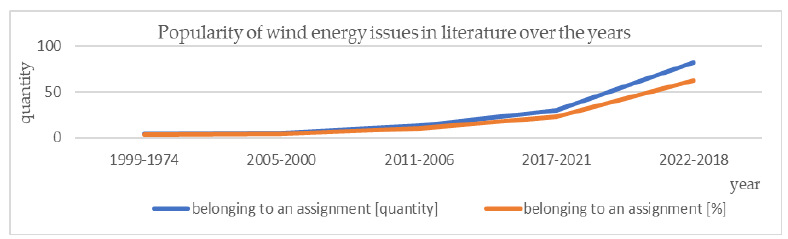
Figure 4. Popularity of wind energy issues in the literature over the years.